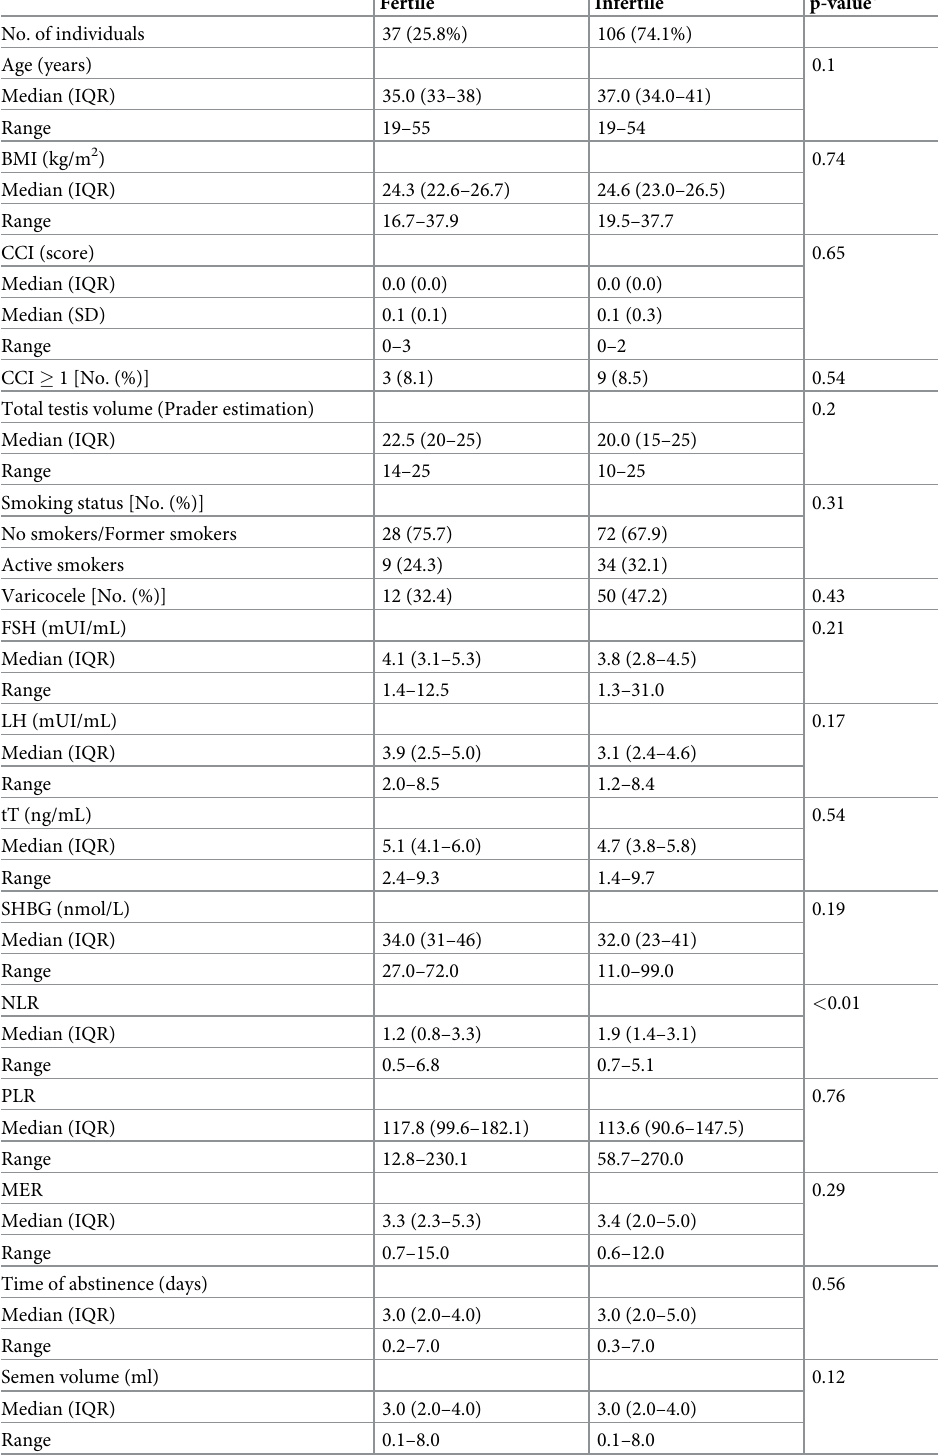
Table 4. Descriptive statistics of participants with isolated teratozoospermia according to fertility status (No. =